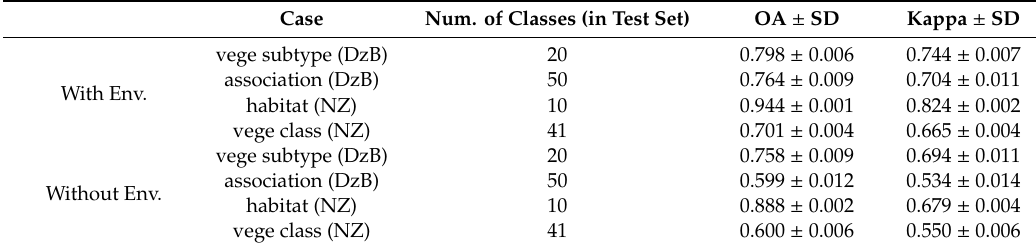
Table 1. Vegetation mapping evaluations with and without environmental data. With Env. represents mapping with environmental data; Without Env. represents mapping without environmental data. SD is standard deviation. Case Num. of Classes (in Test Set) OA ± SD Kappa ± SD vege subtype (DzB) 20 0.798 ± 0.006 0.744 ± 0.007 association (DzB) 50 0.764 ± 0.009 0.704 ± 0.011 With Env. habitat (NZ) 10 0.944 ± 0.001 0.824 ± 0.002 vege class (NZ) 41 0.701 ± 0.004 0.665 ± 0.004 vege subtype (DzB) 20 0.758 ± 0.009 0.694 ± 0.011 association (DzB) 50 0.599 ± 0.012 0.534 ± 0.014 Without Env. habitat (NZ) 10 0.888 ± 0.002 0.679 ± 0.004 vege class (NZ) 41 0.600 ± 0.006 0.550 ±